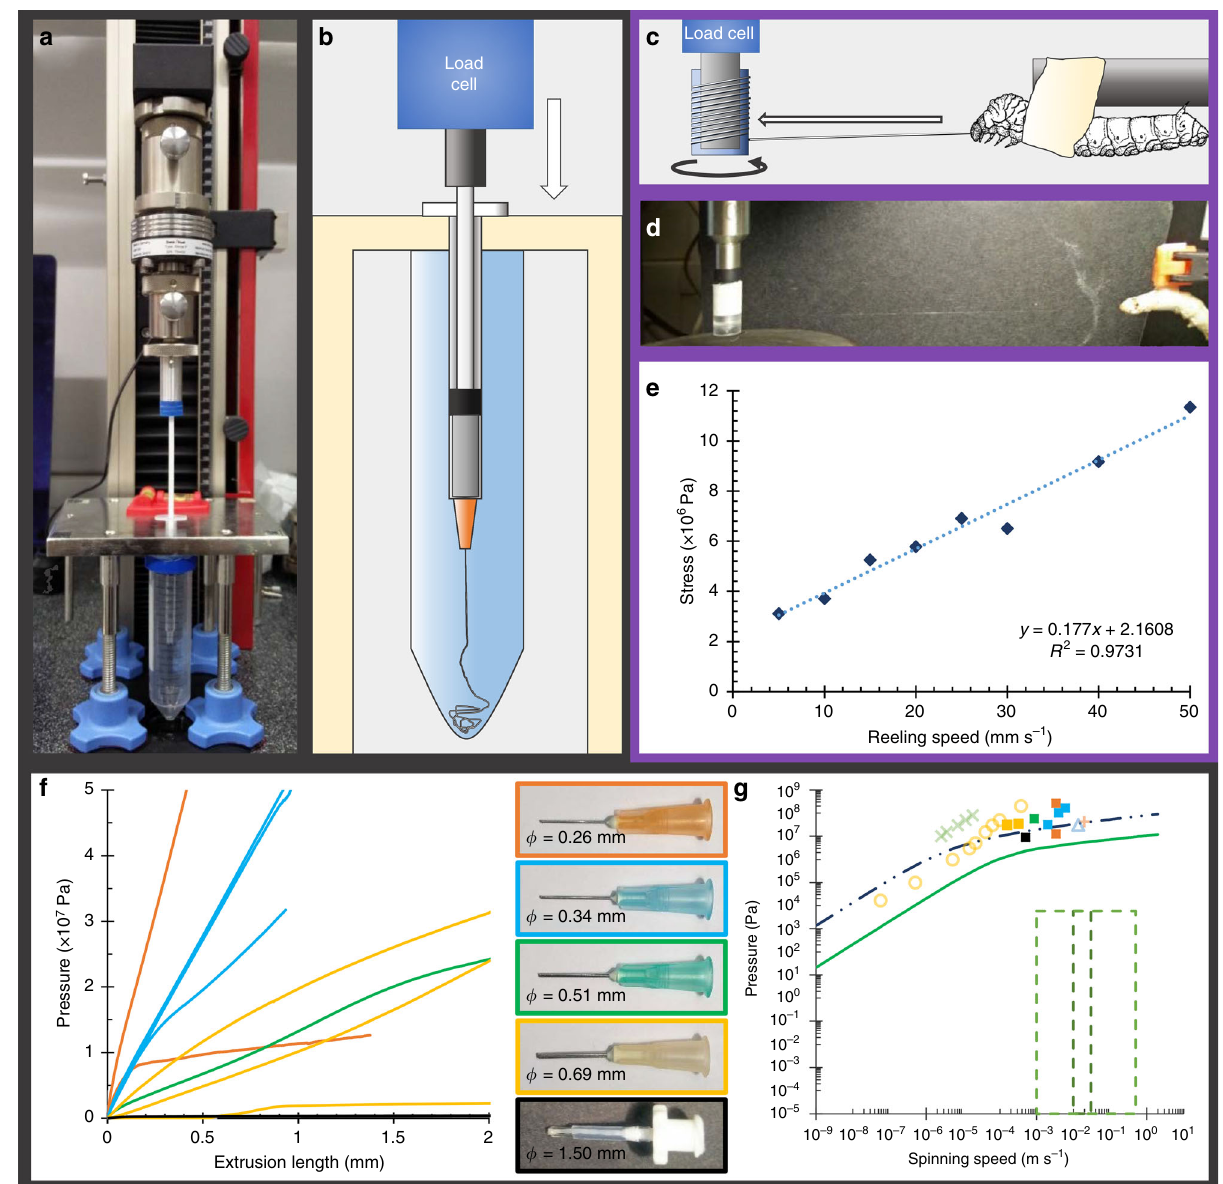
Fig. 9 Experimental validation through extrusion of native silk feedstock and pultruding silk fi bres via forced reeling. a Pushing experimental validation rig: Zwick Z0.5 universal testing machine in compression mode, with hypodermic needle mount and spin tank. b Schematic representation of extrusion device seen in a . c Schematic representing the key components of the forced reeling system (custom geometry/spool and restrained silkworm) used for pultrusion experimental validation. d Take-up spool and silkworm mid-reeling experiment, with a strand of silk visible between the two. e Plotting stress against reeling speed shows an approximately linear relation between the two variables. The stress encountered during forced reeling is of the same order of magnitude (3 – 12 MPa) as the pressure predicted through our computational models (6 – 13 MPa), which supports the argument for pultrusion as the dominant spinning mechanism. f The relationship between the pressure required to extrude native silk feedstock through a non-tapering duct and its diameter is shown. Coloured lines f and fi lled squares g refer to the correspondingly coloured hypodermic needles used as extrusion dies. The internal diameter of each is constant over a 20 mm length, and is provided for each size. Values presented are maximum pressures attained. For lower speeds and larger diameters, the measured forces showed an initial rise to a steady plateau where the sample continued to fl ow through the needle, the value of which is presented in these cases. In the higher speed and/or lower diameter cases, failure during the initial rise in pressure was often experienced, and hence maximum pressure reached is presented as an indicator of minimum pressure required, though it is likely the plateau region would be higher. For clarity, only the fi rst 2 mm of the extruded length are shown, for an overview of the entire extrusion process, see Supplementary Fig. 4. g Comparison of our experimental data with previous simulations (Kojic (2006), orange plus ; Moriya (2008), yellow circles ; Moriya (2009), green x ; Breslauer (2009), blue triangle ), our extension of Kojic ’ s work ( blue dot-dashes ), and the limiting case of our geometric explorations ( pale green ) (see Fig. 5) shows good agreement, with pressures of similar magnitudes to those predicted through simulation required to extrude native silk feedstock through a